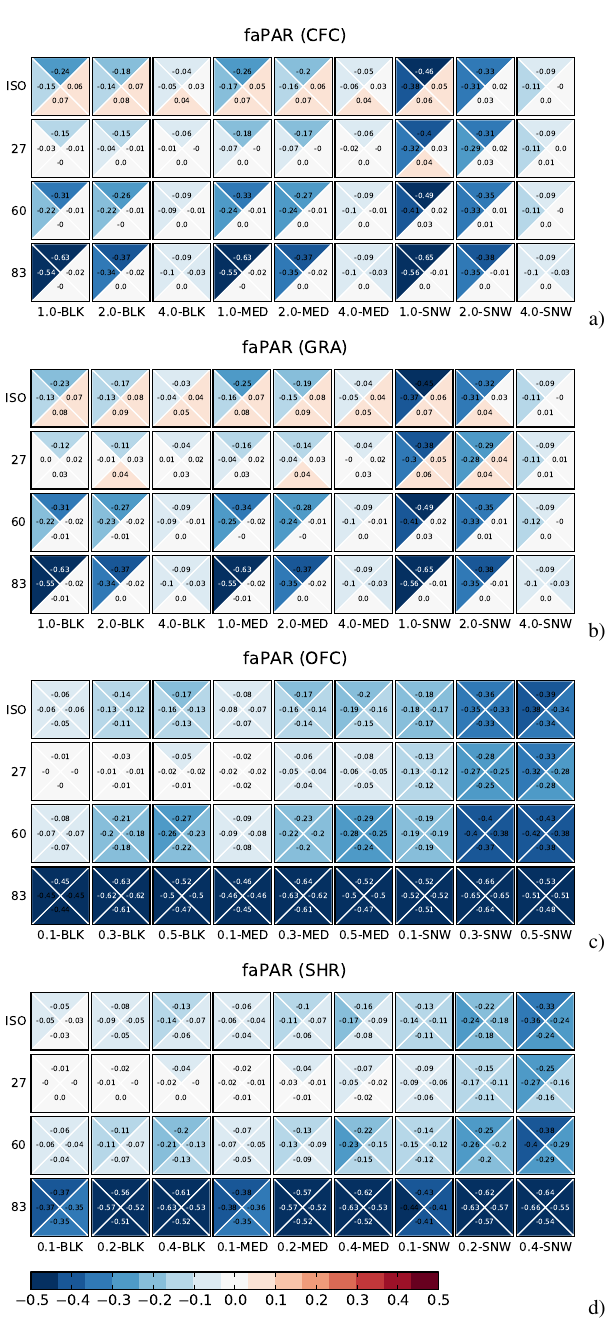
Fig. 3. Differences in faPAR between canopy RT models and RAMI4PILPS for different experiments (model-RAMI4PILPS); columns corre- spond to different leaf area or vegetation fraction and soil brightness (see Table 1) while rows correspond to different illumination sun zenith angles (degree); ISO=isotropic illumination ( θ ); Triangles correspond to different models: left=ORCHIDEE, right=JULES, top=JSBACH, bottom=JSBACH without clumping